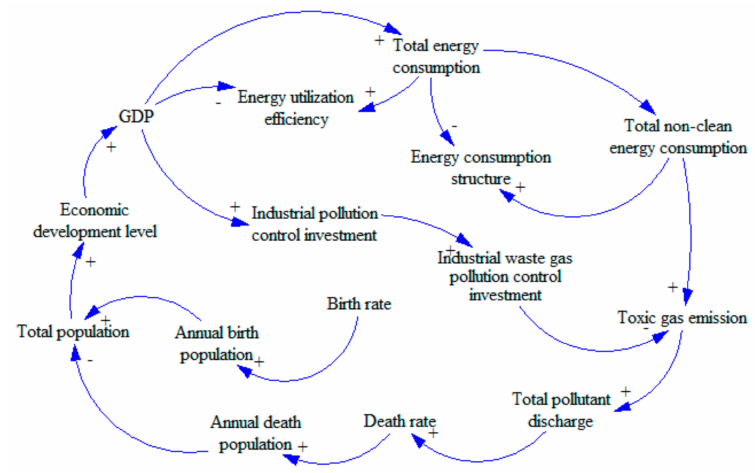
Figure 3. Causality diagram of China’s energy subsystem.